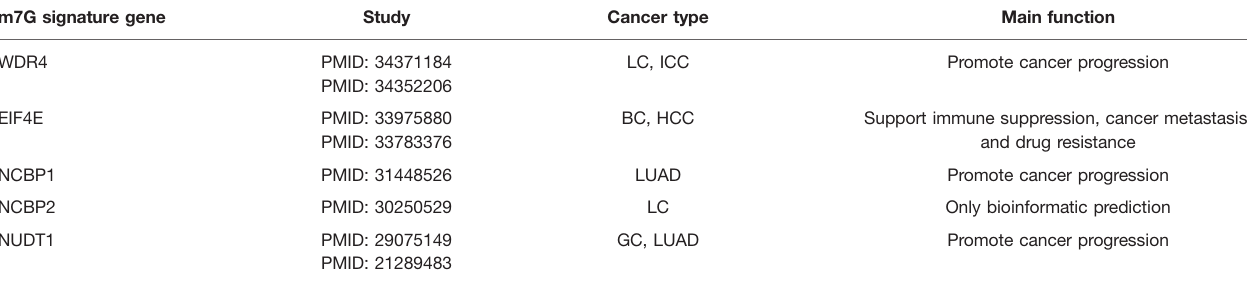
TABLE 2 | Main roles of m7G signature genes in multiple